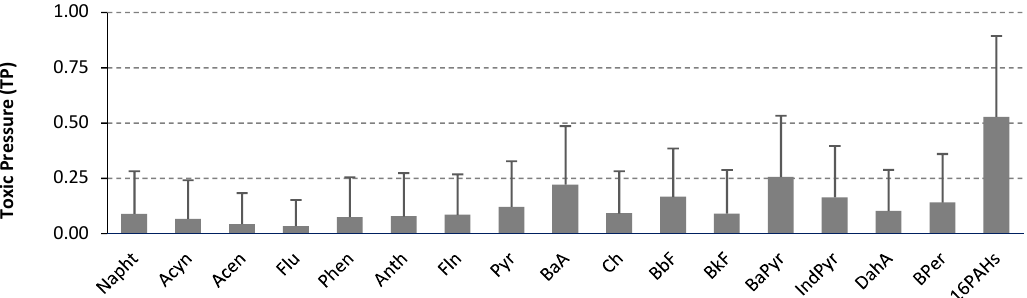
Figure 1. Average toxic pressure (TP) for the individual hydrocarbons and for the mixture of 16PAHs (n = 74), bar indicates the standard deviation. Table 4. Percentage share of soil samples in individual classes of toxic pressure (TP); TP classification